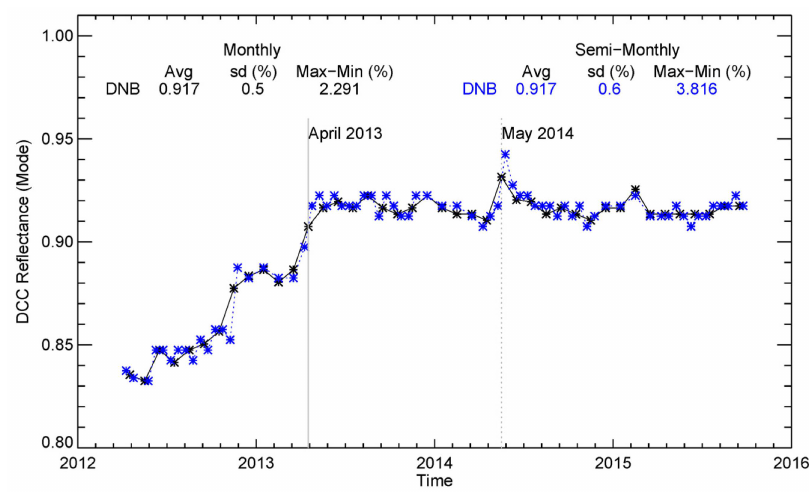
Figure 10. Monthly (black solid line) and semi-monthly (blue dash line) DNB DCC mode time series (April 2012–September